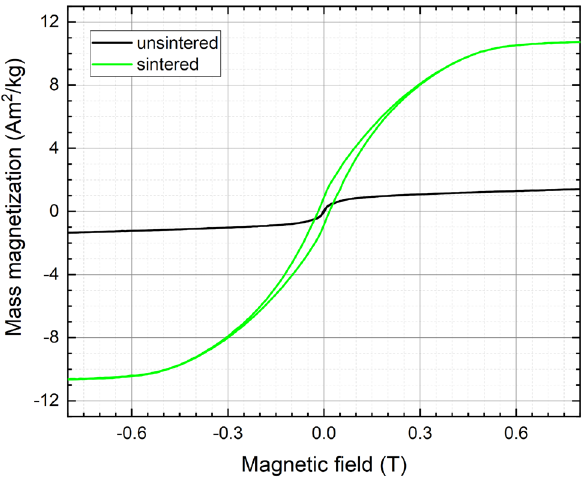
Figure 9. Magnetic hysteresis loops of the FeRh nanoparticle ink recorded before and after laser sintering (6 W), after subtraction of the diamagnetic glass-substrate